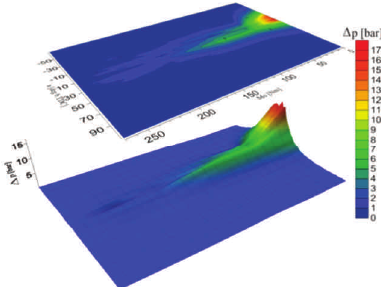
Fig. 2. Influence of crank angle of engine and engine load on pressure changing inside engine cylinder as a result of EGR valve